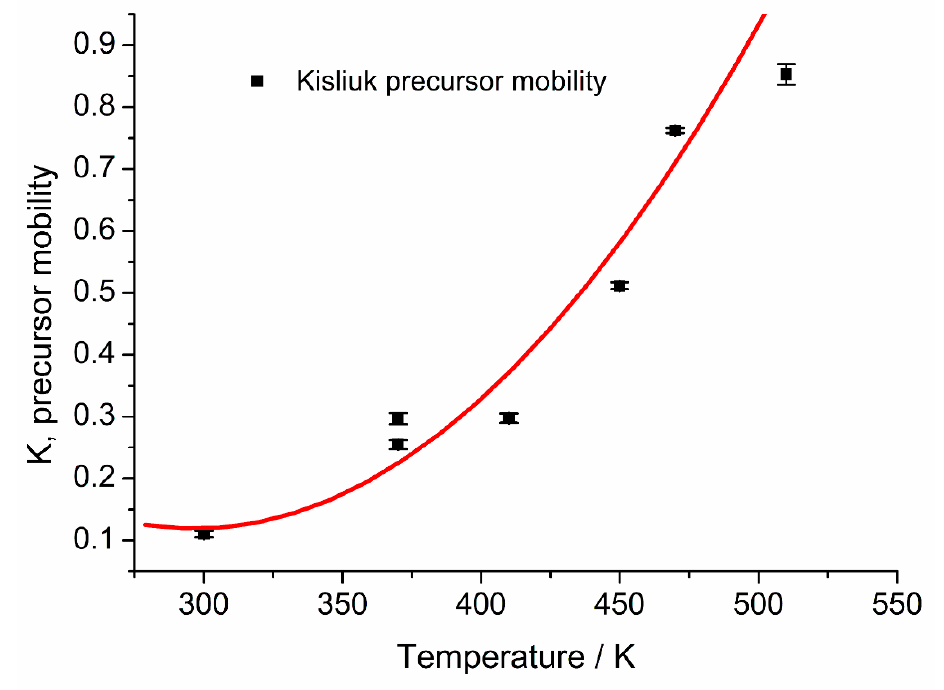
Figure 9. The dependence of the Kisliuk precursor mobility parameters for CO adsorption on Pt{110} with temperature.